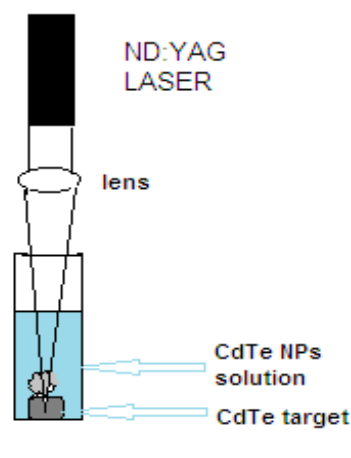
Fig.1: Experimental set-up for colloid preparation by laser ablation.